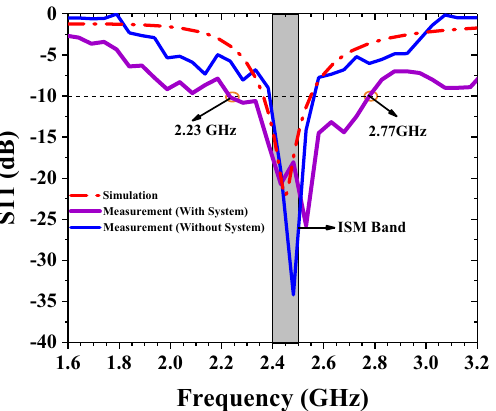
Figure 5. The simulated and measured return loss of the antenna with or without a pacemaker system.